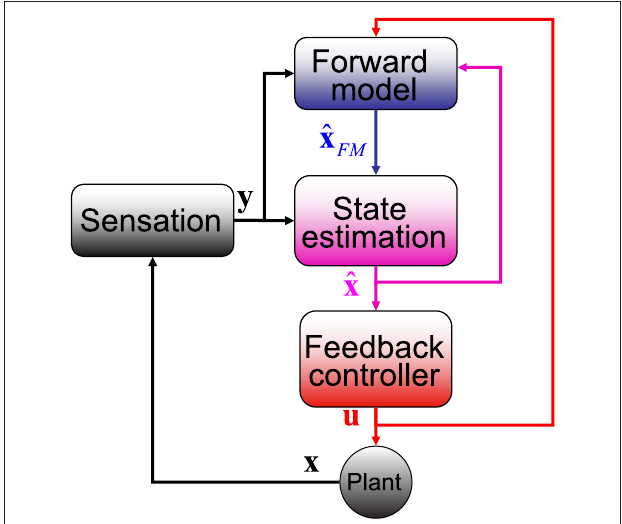
FIGURE 3 | The SPFC framework proposes that a feedback controller is optimized to produce motor commands that achieve task goals. In order to do this effectively, it uses an estimate of the current situation that is derived from a combination of feedback from the sensory system and forward model estimation that depends on efferent